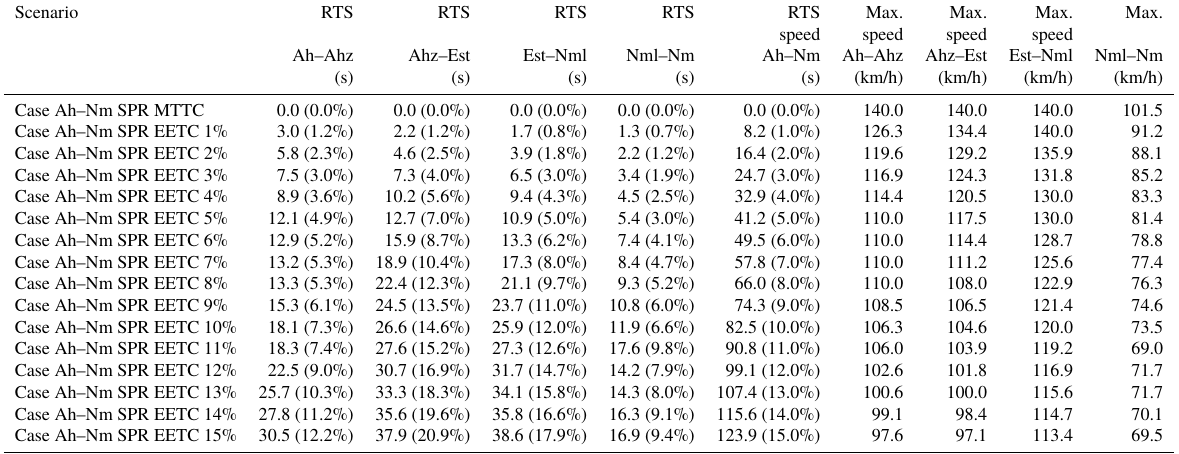
Table 10: Optimal running time supplement distribution for SPR for each section of the different real-world case Ah-Nm scenarios. Scenario RTS RTS RTS RTS RTS Max. Max. Max. Max. speed speed speed speed Ah–Ahz Ahz–Est